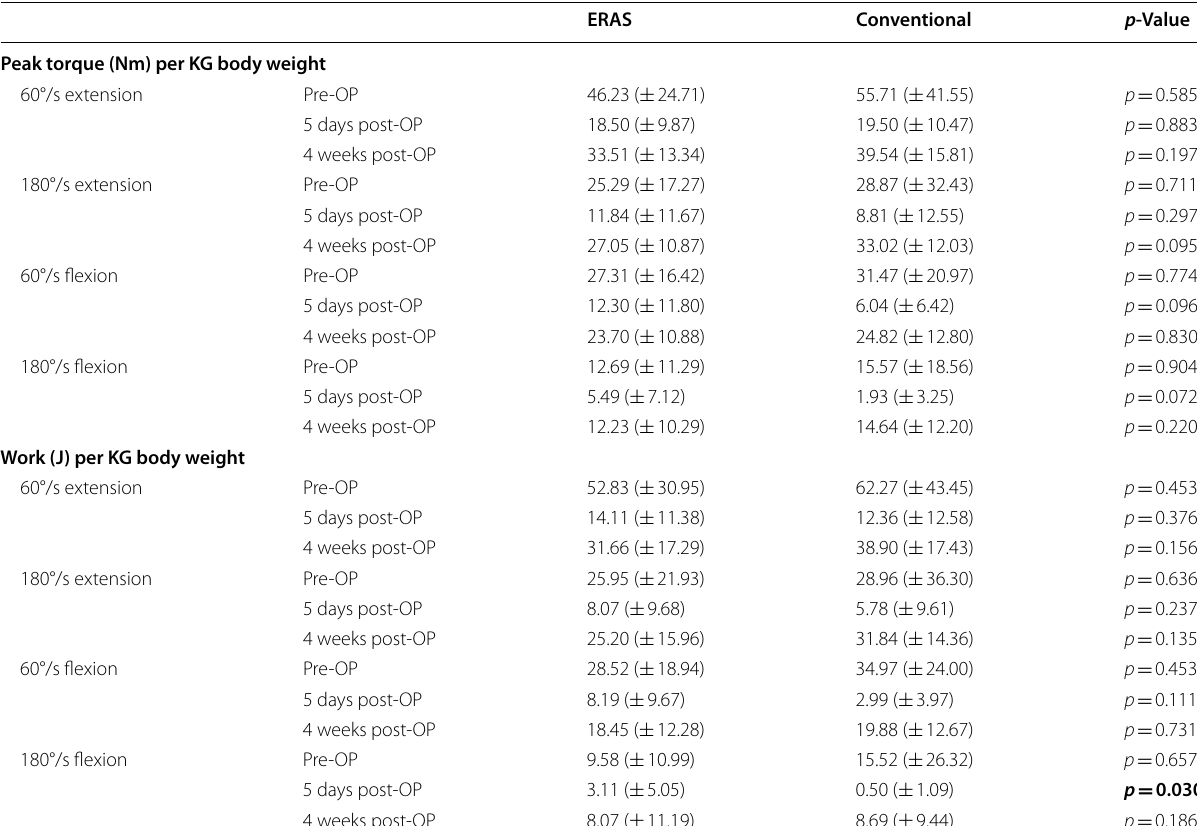
Table 4 Mean value and standard deviation of peak torque (Nm) and work (J) per KG body weight preoperatively and 5 days and 4 weeks after surgery with enhanced recovery or conventional